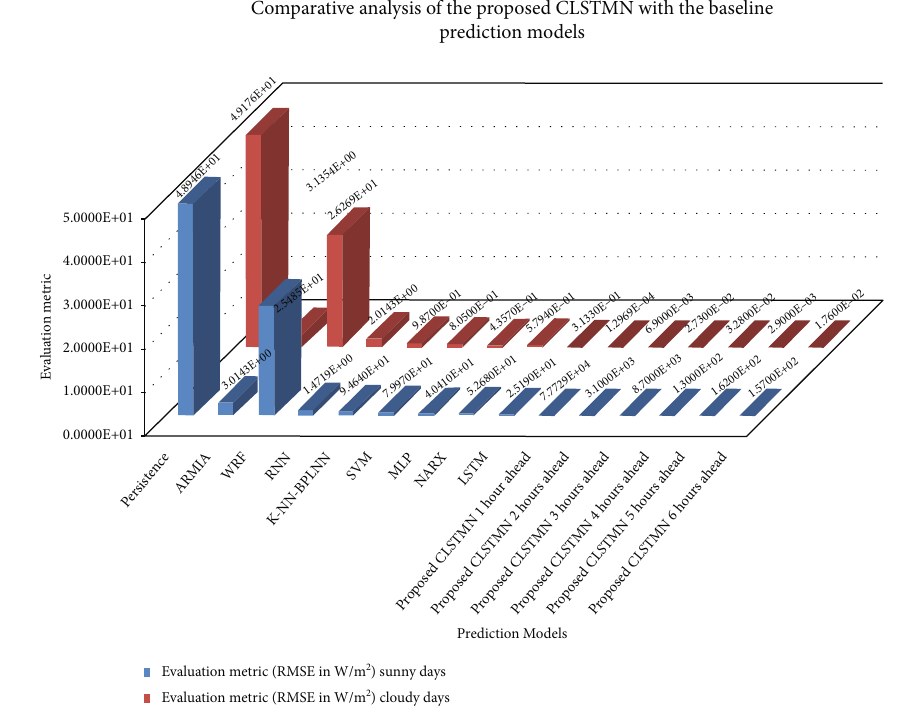
Figure 40: Comparative analysis of the proposed CLSTMN with the baseline prediction